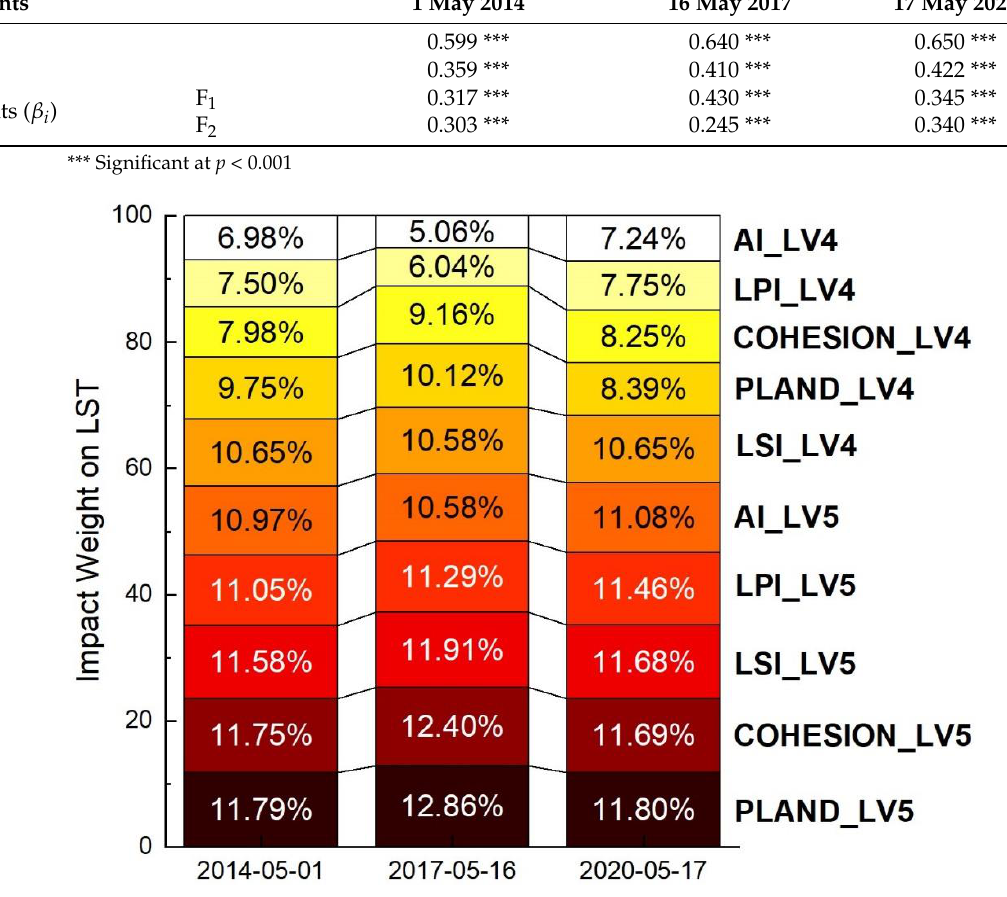
Figure 9. The impact weight of the class level landscape metrics of IPSD LV4 or LV5 on LST.